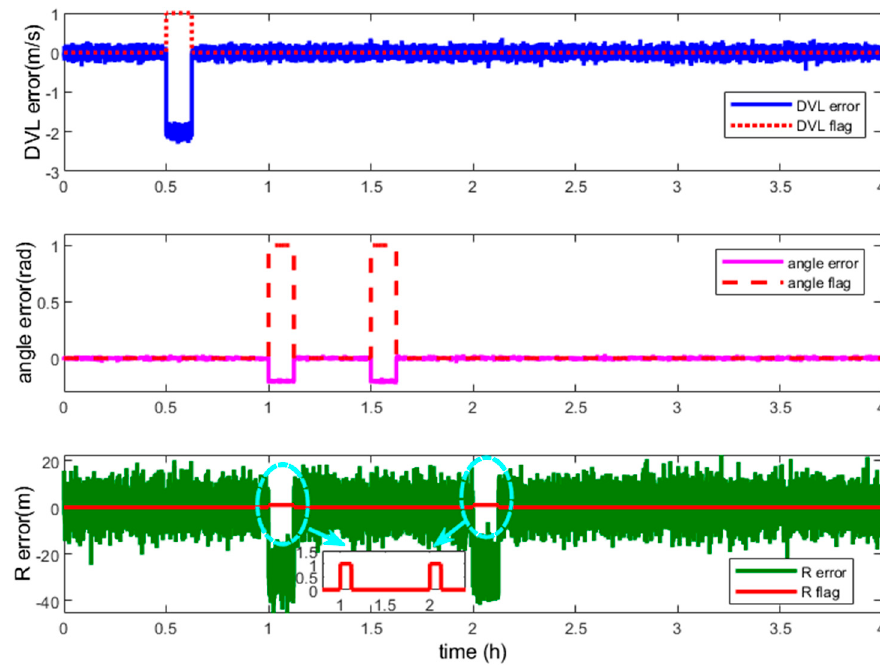
Figure 6. Description of the measurement fault and detection flags.